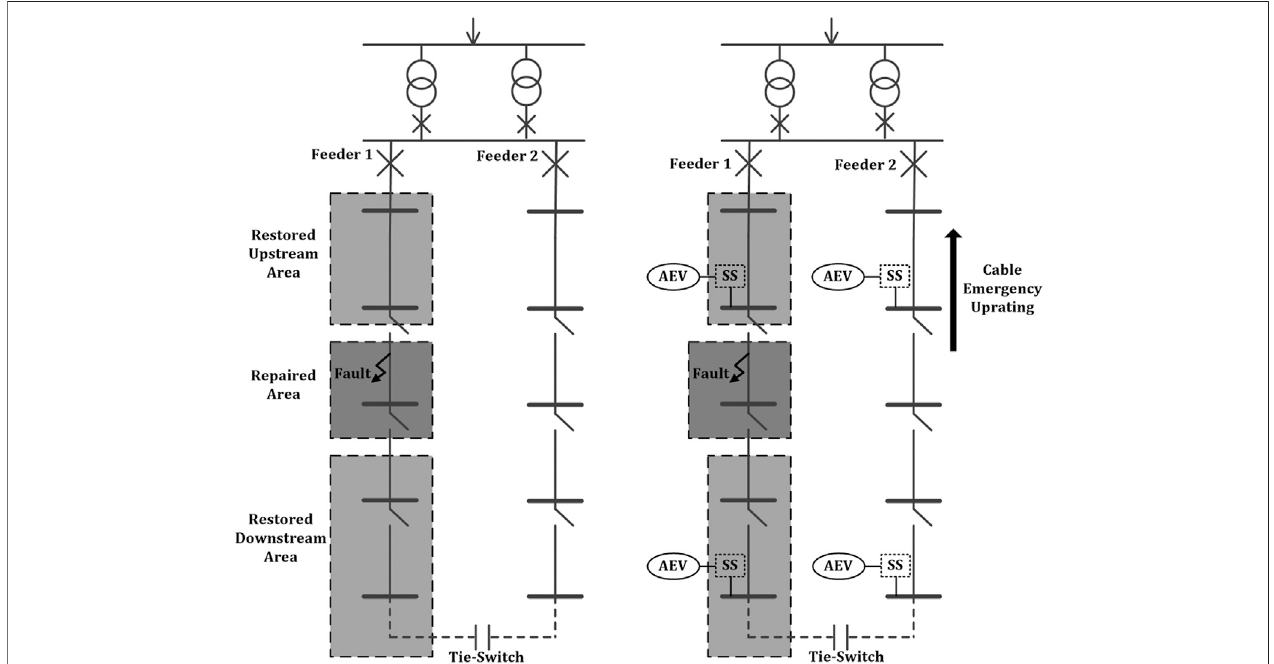
FIGURE 3 | An example of power restoration in a two-legged ring network with or without EV connection.